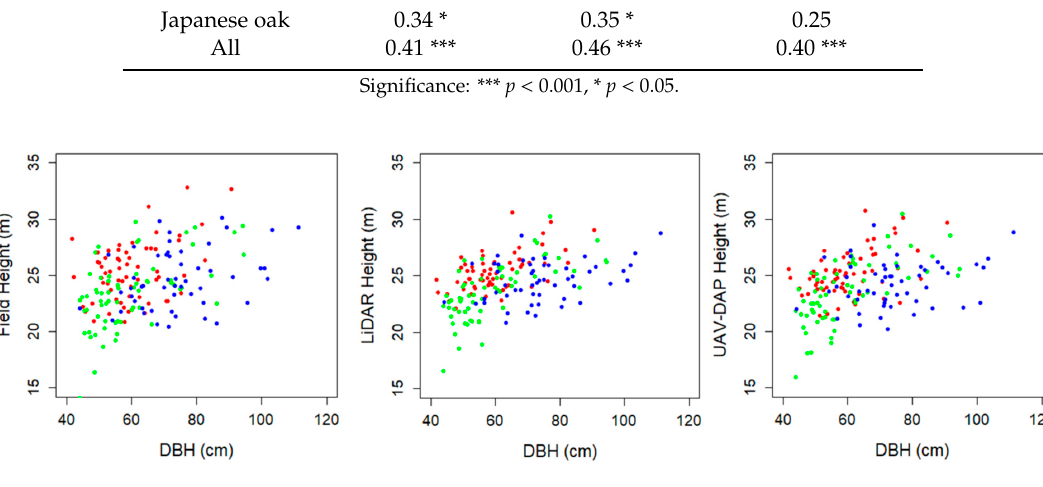
Figure 5. Correlation between individual tree DBH and tree height derived from Field, LiDAR, and UAV-DAP. Red, green, and blue dots represent individual monarch birch, castor aralia, and Japanese oak tree